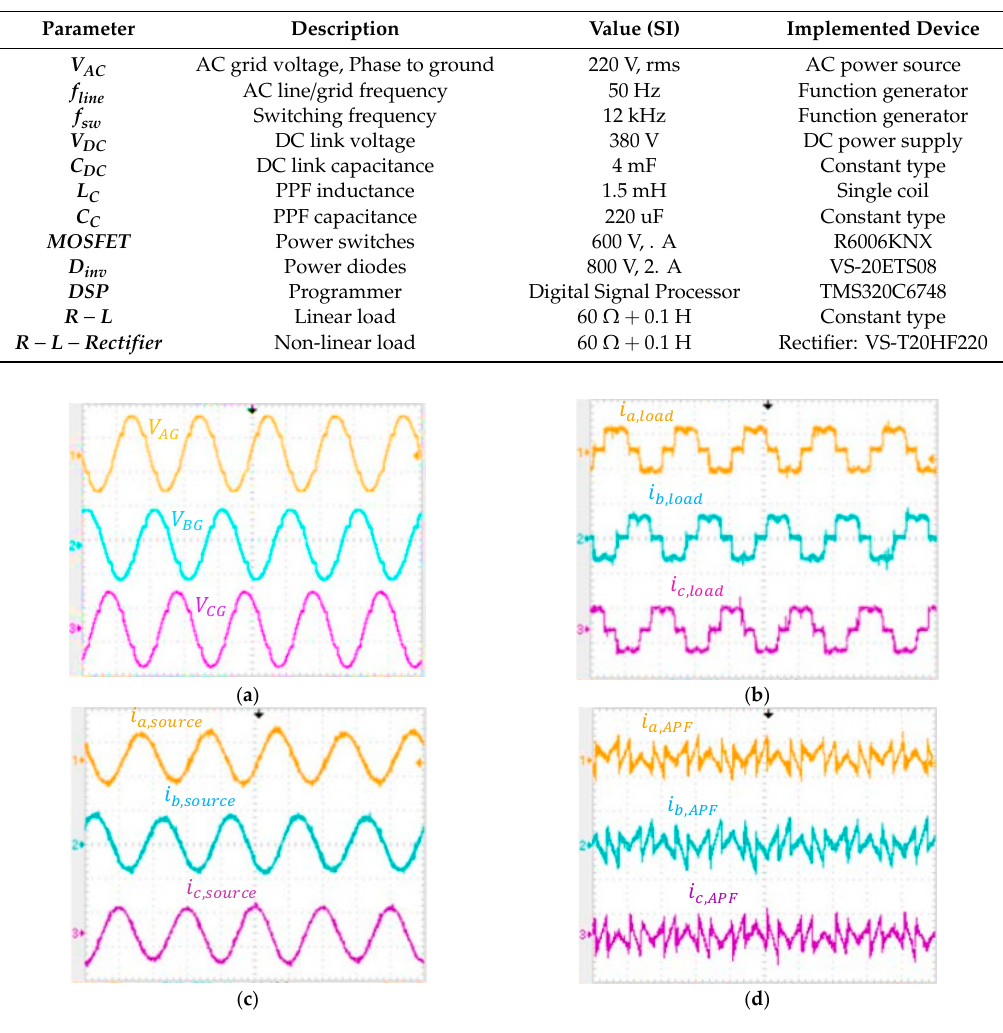
( b ) Figure 7. Current THD; ( a ) source current, ( b ) load current.